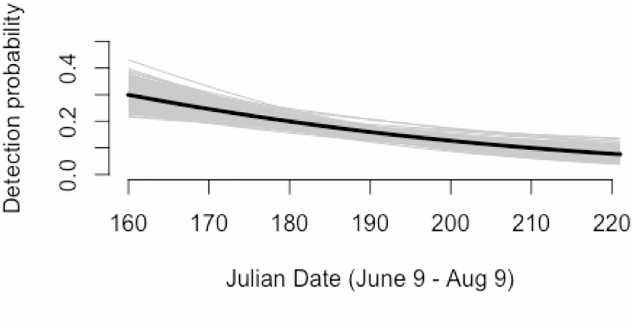
Fig 3. Predictions of the relationship between Julian date and kestreldetection probability p . Black line shows posterior mean, and gray lines show the relationship based on a randomposterior sample of size 200 to visualizeestimation